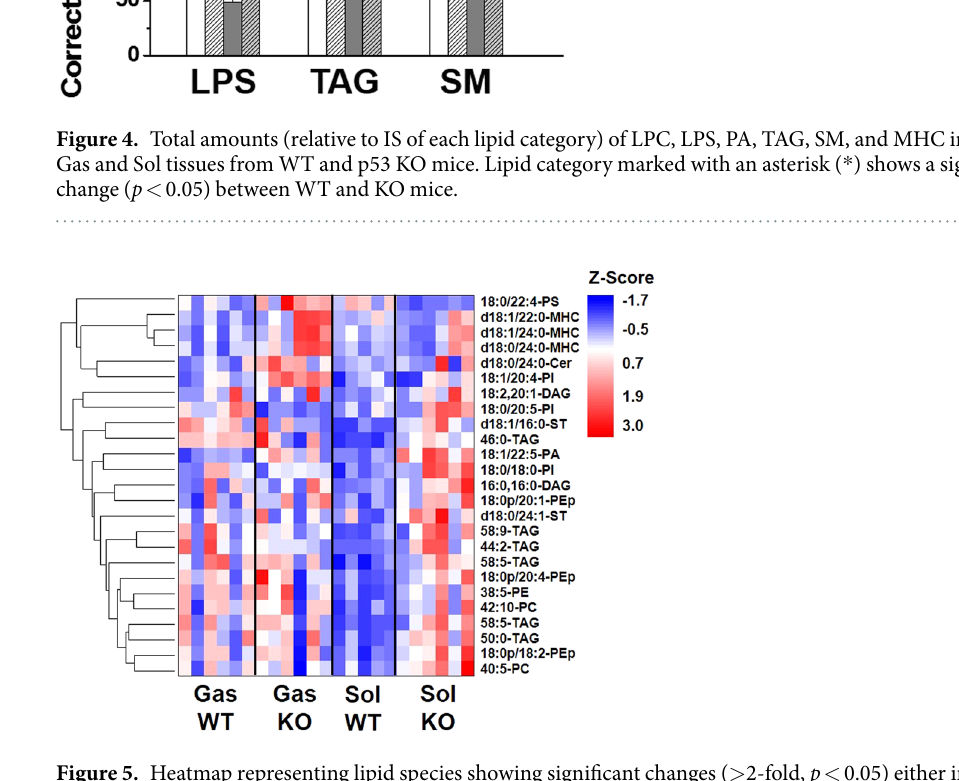
Figure 5. Heatmap representing lipid species showing significant changes ( > 2-fold, p < 0.05) either in the Gas or Sol tissues of WT and KO